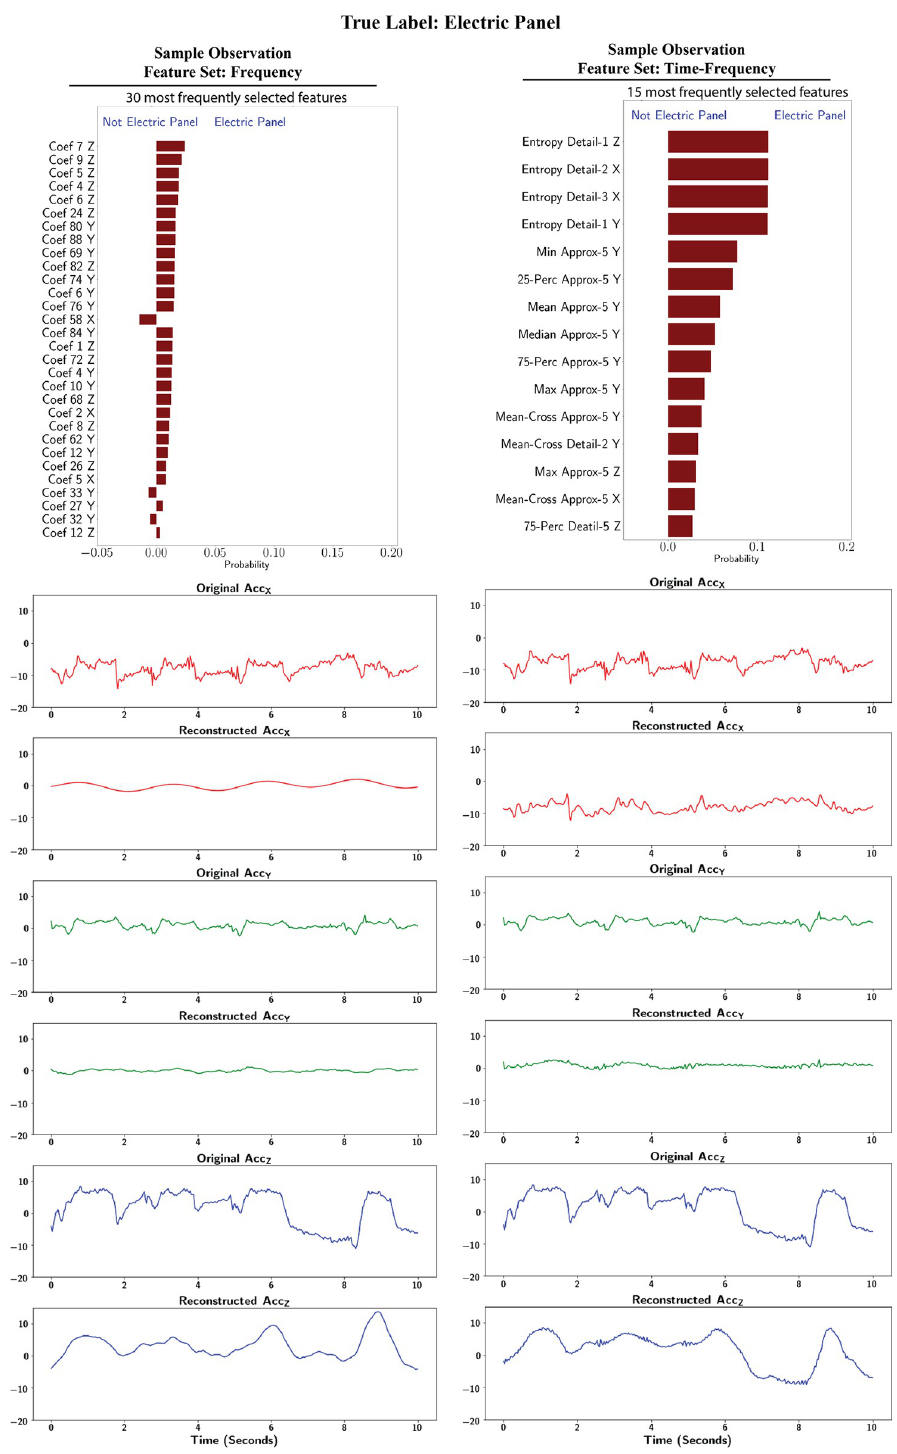
Fig 7. LIME interpretation: Class specific feature importance and reconstruction for electric